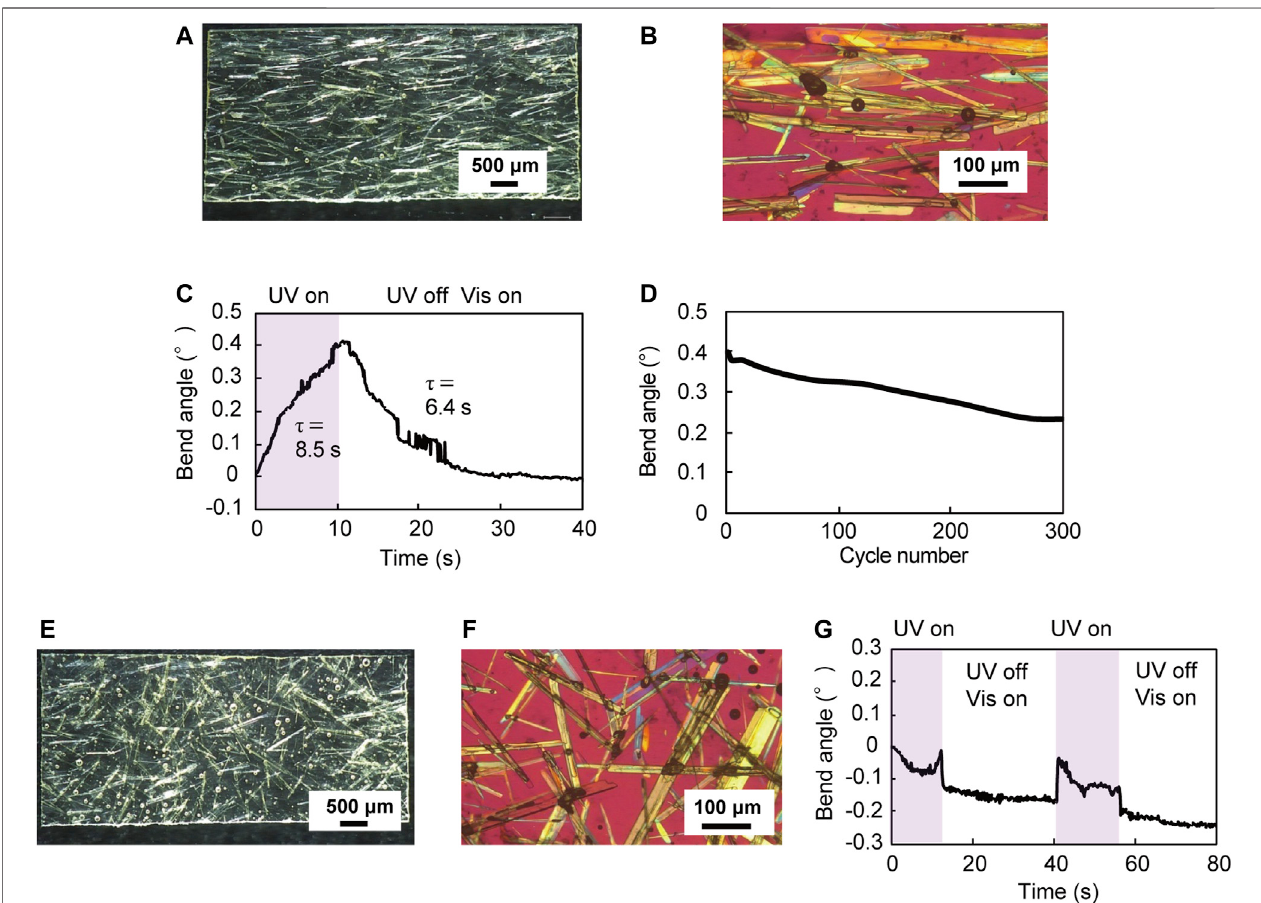
FIGURE 4 | (A) A UV-cured resin hybrid fi lm (7.1 mm long × 3.2 mm wide × 153 μ m thick) in which enol- 1 crystals are aligned by rubbing. (E) A UV-cured resin hybrid fi lm (7.0 mm long × 3.2 mm wide × 155 μ m thick) in which enol- 1 crystals are not aligned. (B,F) Enlarged polarized microscopic images of (B) the fi lm in which enol- 1 crystalsarealignedand (F) the fi lminwhichenol- 1 crystalsarenotaligned. (C,G) Timedependence ofbendangleuponUV-LEDirradiationof (C) the fi lminwhich enol- 1 crystals are aligned and (G) the fi lm in which enol- 1 crystals are not aligned. ( D ) Repeatability of the reversible bending of the aligned fi lm over 300